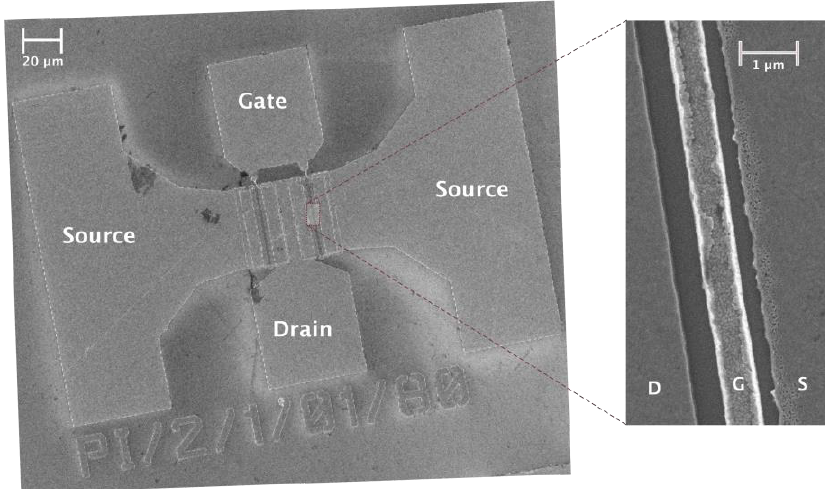
Figure 1. ( Left ) SEM image of a Π -gate Si/SiGe MODFET under study; ( Right ) Zoom detailing the top view of the lateral structure of the metal gate, drain and source contacts. The Schottky-gate is placed in a slightly asymmetric position between the source and the drain on the device channel.